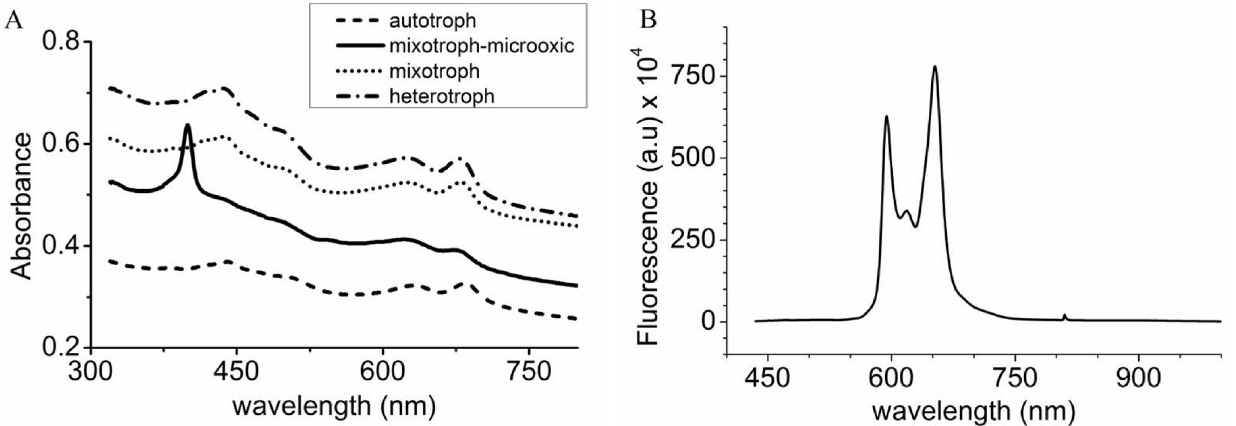
Fig 3. Absorption and fluorescence spectra of G . sulphuraria 074G whole cells and culture medium. (A) Absorption spectra of G . sulphuraria 074G cells grown under various conditions. Absorption peak at 680 nm and at 618 nm corresponds to chlorophyll a and phycocyanin, respectively, and the absorption peak at 400 nm belongs to a porphyrin-like compound. (B) Fluorescence spectra of the medium at day 24 from G . sulphuraria 074G grown under mixotrophic condition with limited oxygen amounts. Excitation spectrum at 457 nm, the fluorescence emission spectrum was obtained upon excitation at the maximum of the Soret